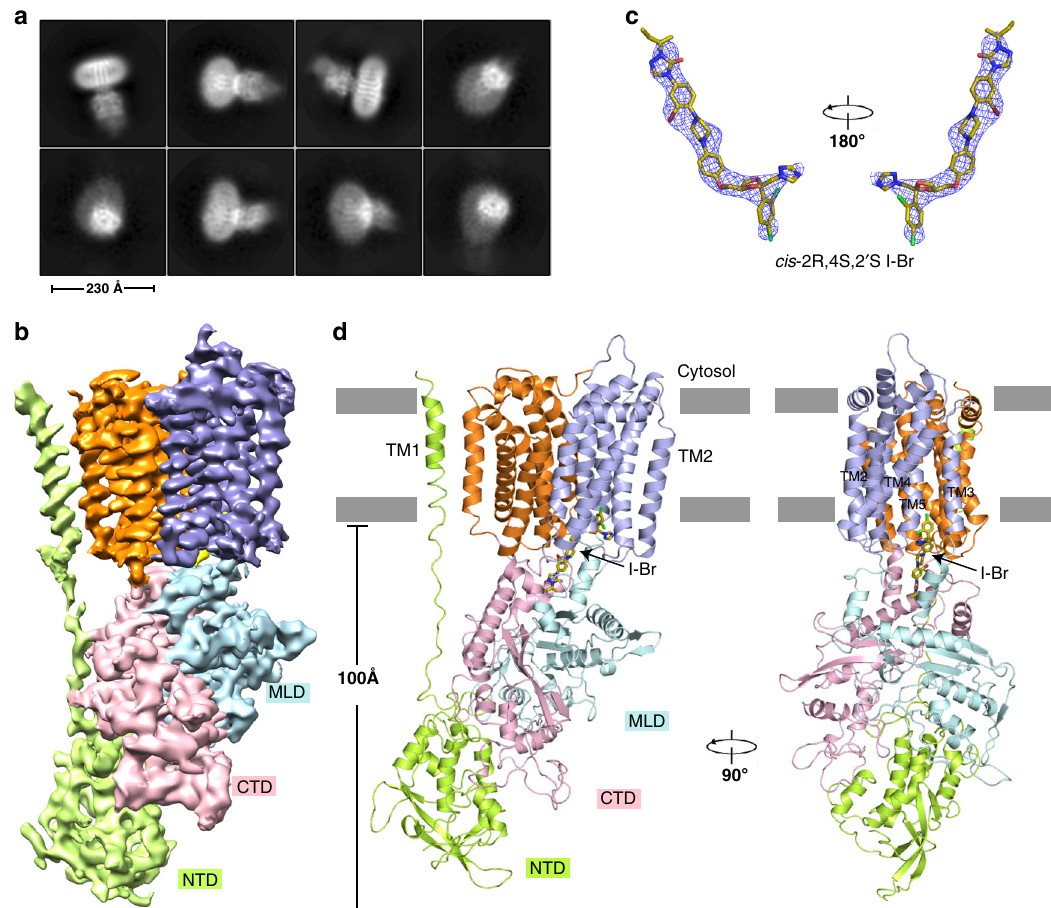
Fig. 3 Overall structure of human NPC1 bound to I-Br. a Cryo-EM 2D classi fi cation from RELION-3. b Cryo-EM map after fi nal RELION-3 re fi nement sharpened using postprocessing. c Cryo-EM map of I-Br at 6 σ level at 4.0 Å resolution. I-Br is shown as sticks with carbon atoms colored in yellow. d Ribbon representation of the structure viewed from the side of the membrane. In this and succeeding fi gures, NTD and TM1, MLD, CTD, TMs 2-7, and TMs 8-13 are shown in green, light cyan, pink, light blue, and orange,